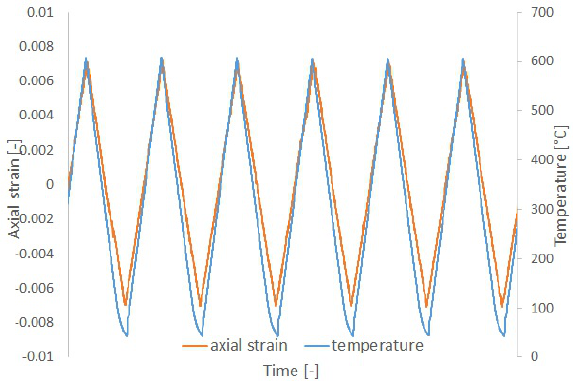
Figure 7. Time dependence of axial strain and tem- perature during the out-of-phase TMF